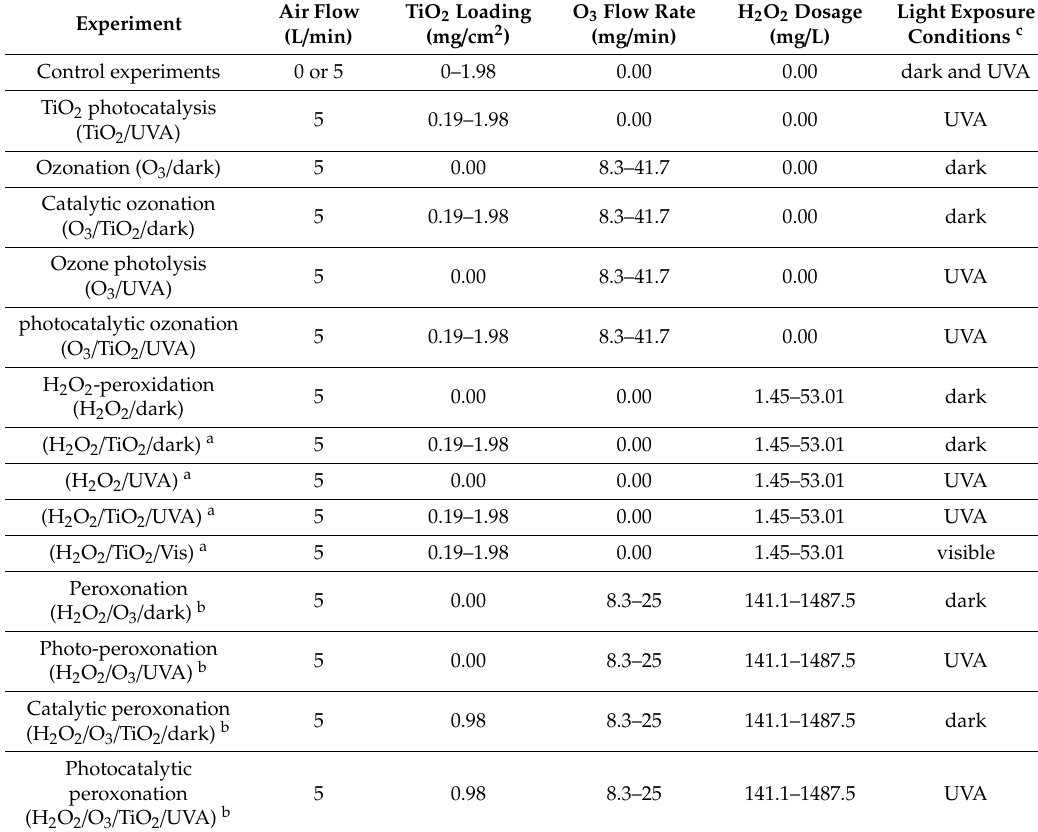
Table 3. Matrix of experimental